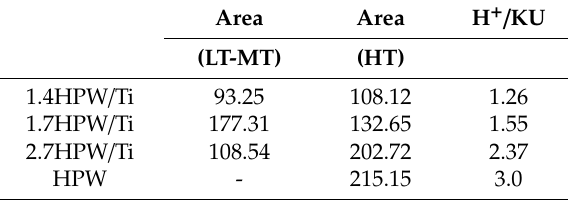
Table 2. Quantitative data from TPD-NH 3 profiles of xHPW / Ti acid